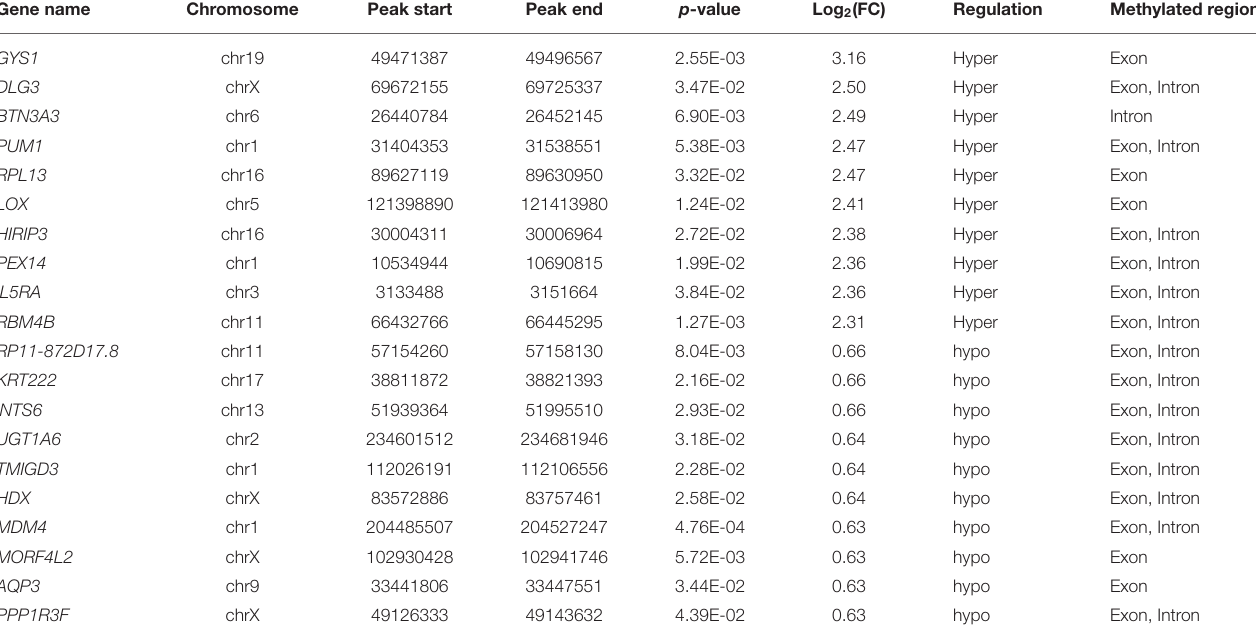
TABLE 1 | The top 20 differentially methylated mRNAs based on